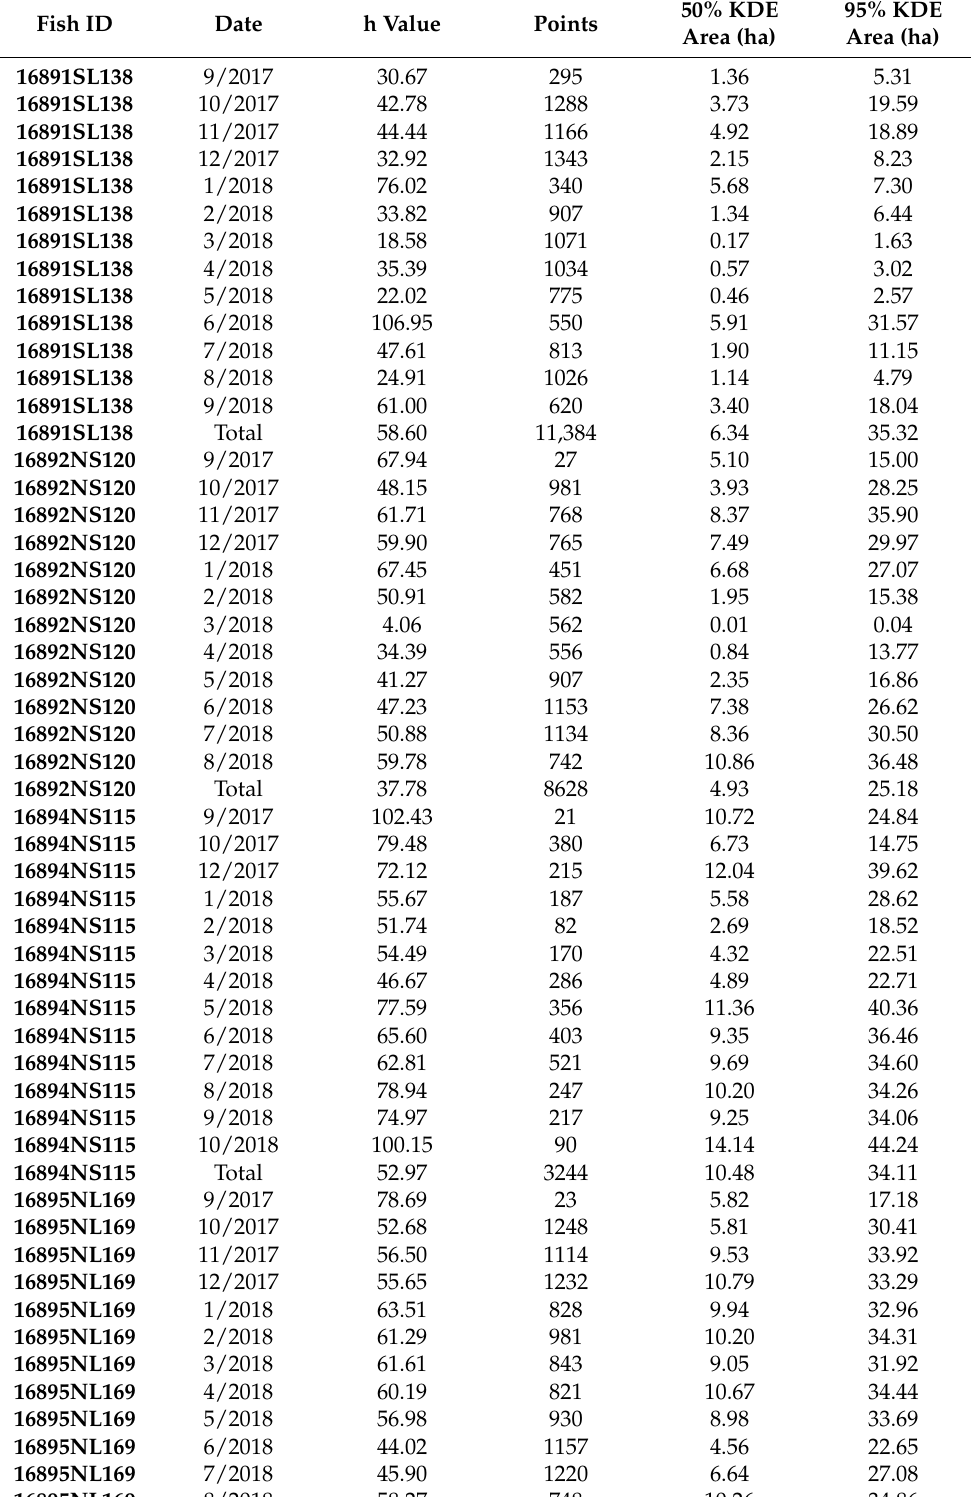
Table A1. Monthly and total home range areas (50% KDE and 95% KDE) of individual fish were calculated using COA estimates and a reference bandwidth